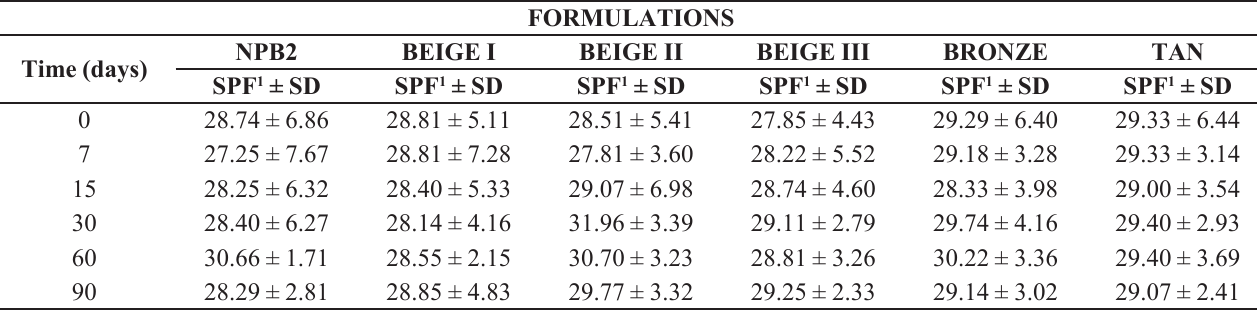
TABLE XIII - Results of SPF variation tests of the NPB2 base and corrective makeup stored at room temperature (23.0 ± 2.0 ºC) for up to 90 days